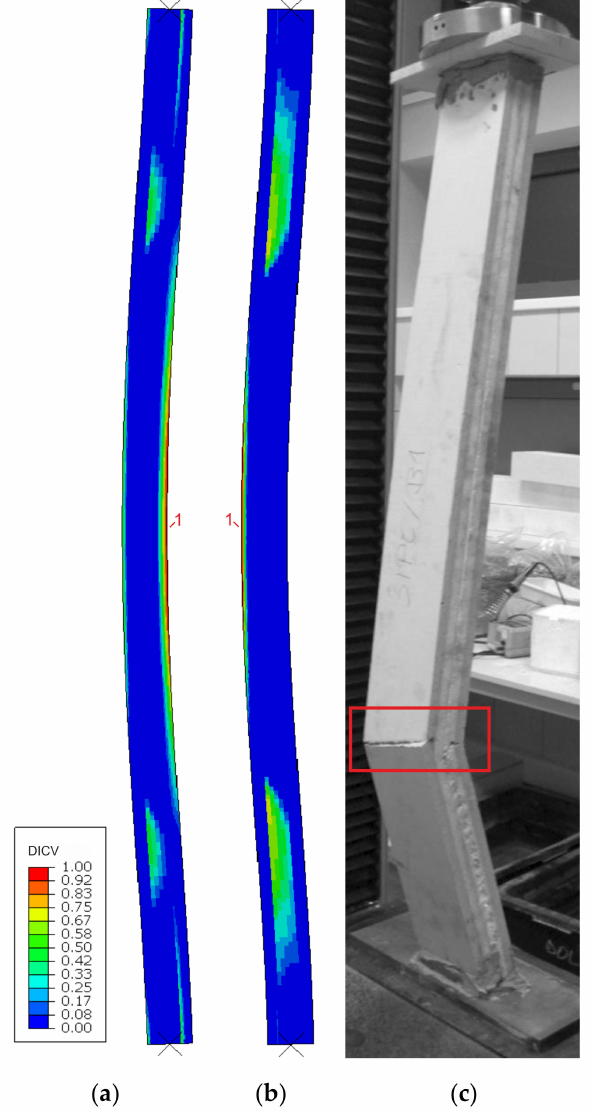
Figure 10. Comparison of failure modes in the L3 sample compression test obtained from FEA ( a ) MgO min, ( b ) MgO max variants, and ( c ) experimental observation. Force–displacement, F x ( u x ), experimental curves for individual samples,